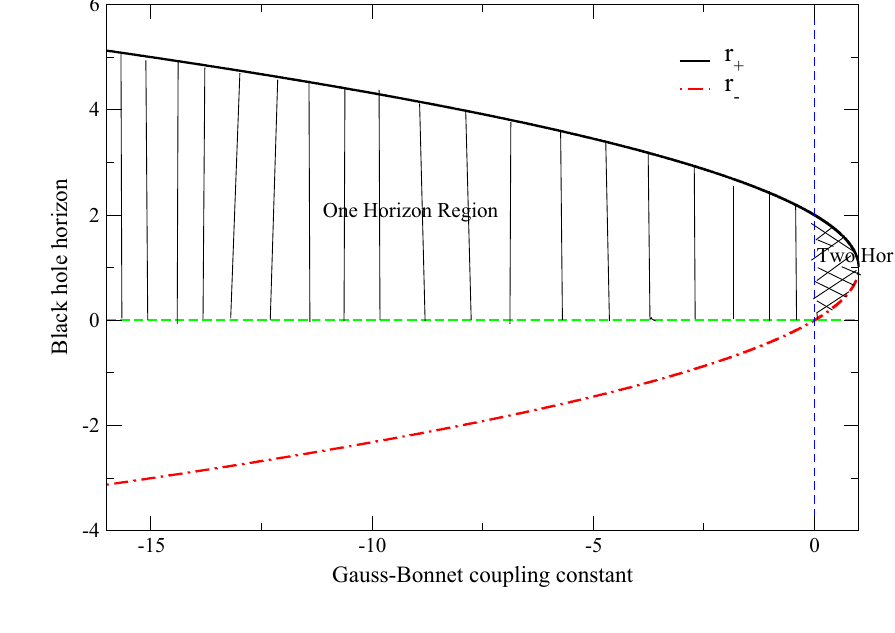
Fig. 1 Black hole horizon radius r + and r − as a function of the Gauss–Bonnet coupling